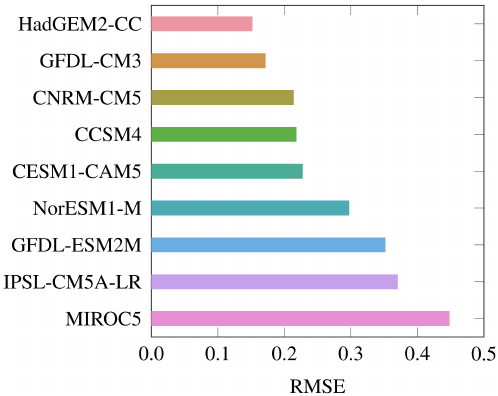
Figure 20. The RMSEs of SICs between CMIP5 and ERA5 from January 2006 to September 2020 in sub-region No. 2.